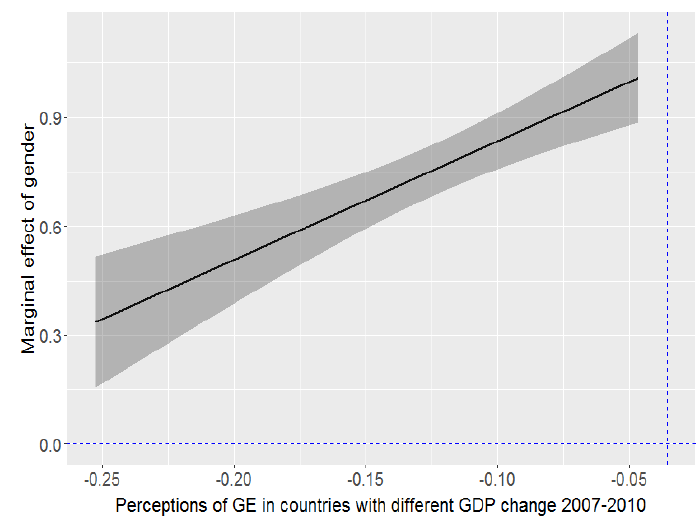
Figure 2 . Effect of gender upon perceptions of gender equality in countries with different GDP change